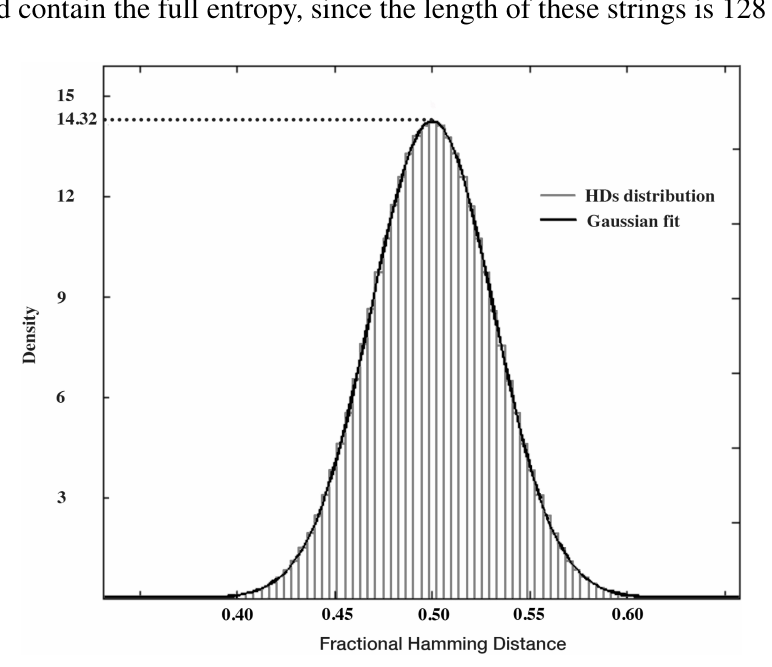
Figure 3. Hamming distance